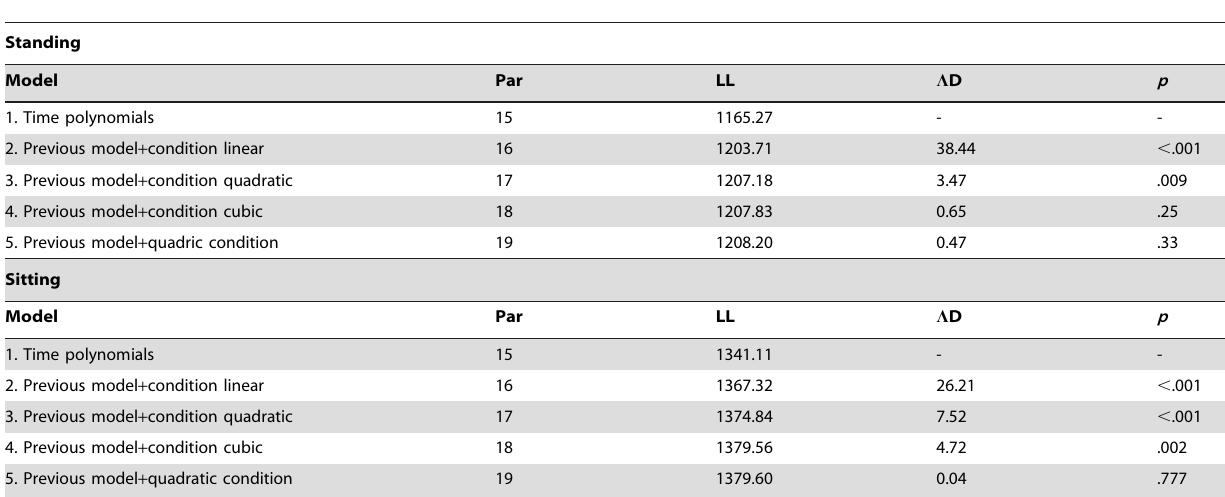
Table 2. Summary of the growth curve analyses for the standing and sitting experiments.